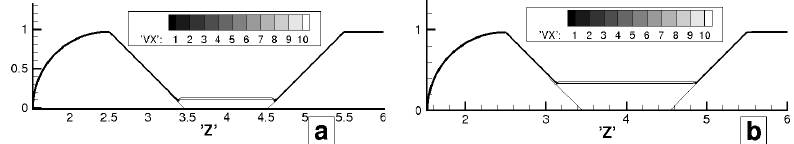
Figure 12. The liner positions in the time of calculation stop: (a) U A 0 = − 100 ( t = 0 . 139 ms); (b) U A 0 = − 1000 ( t = 0 . 113